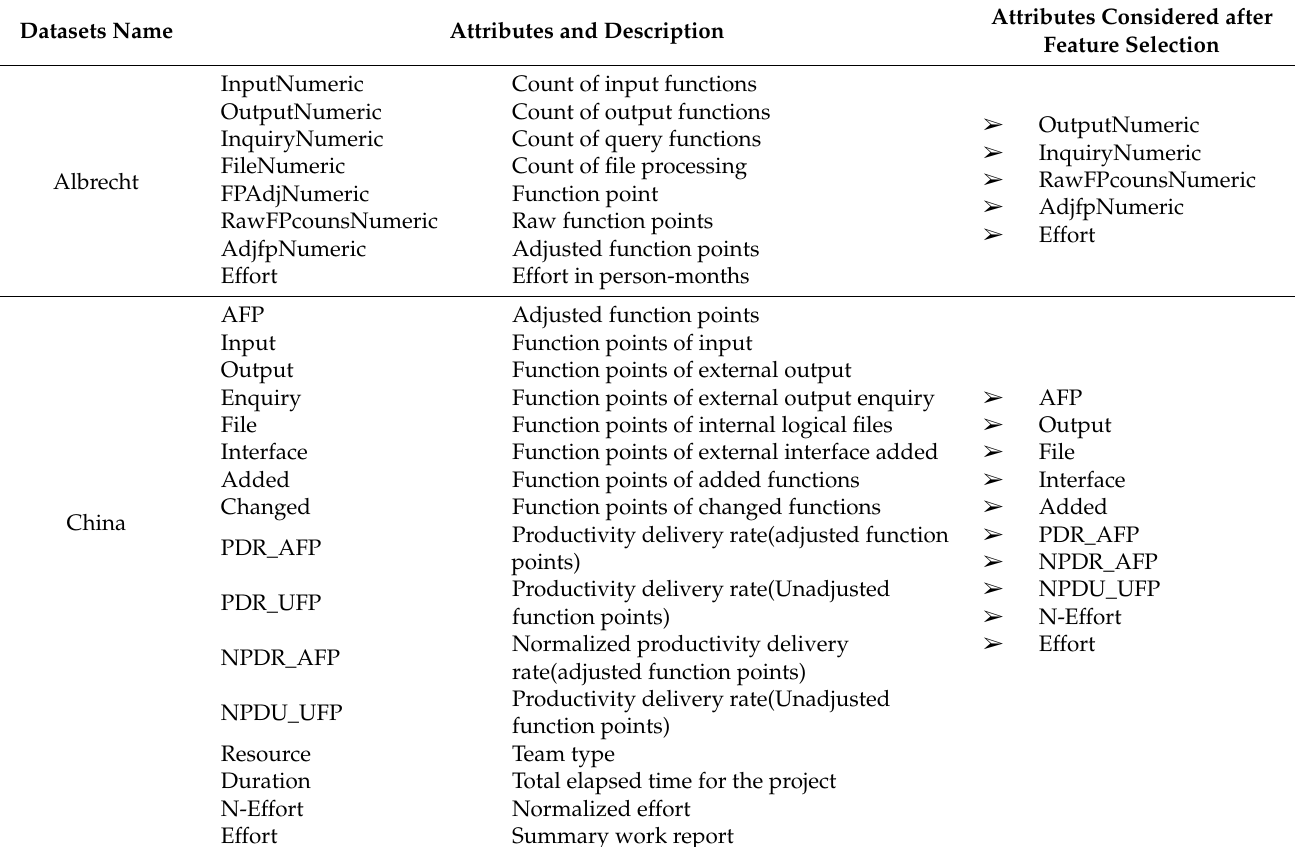
Table 3. Datasets – Original attributes and attributes considered after Feature